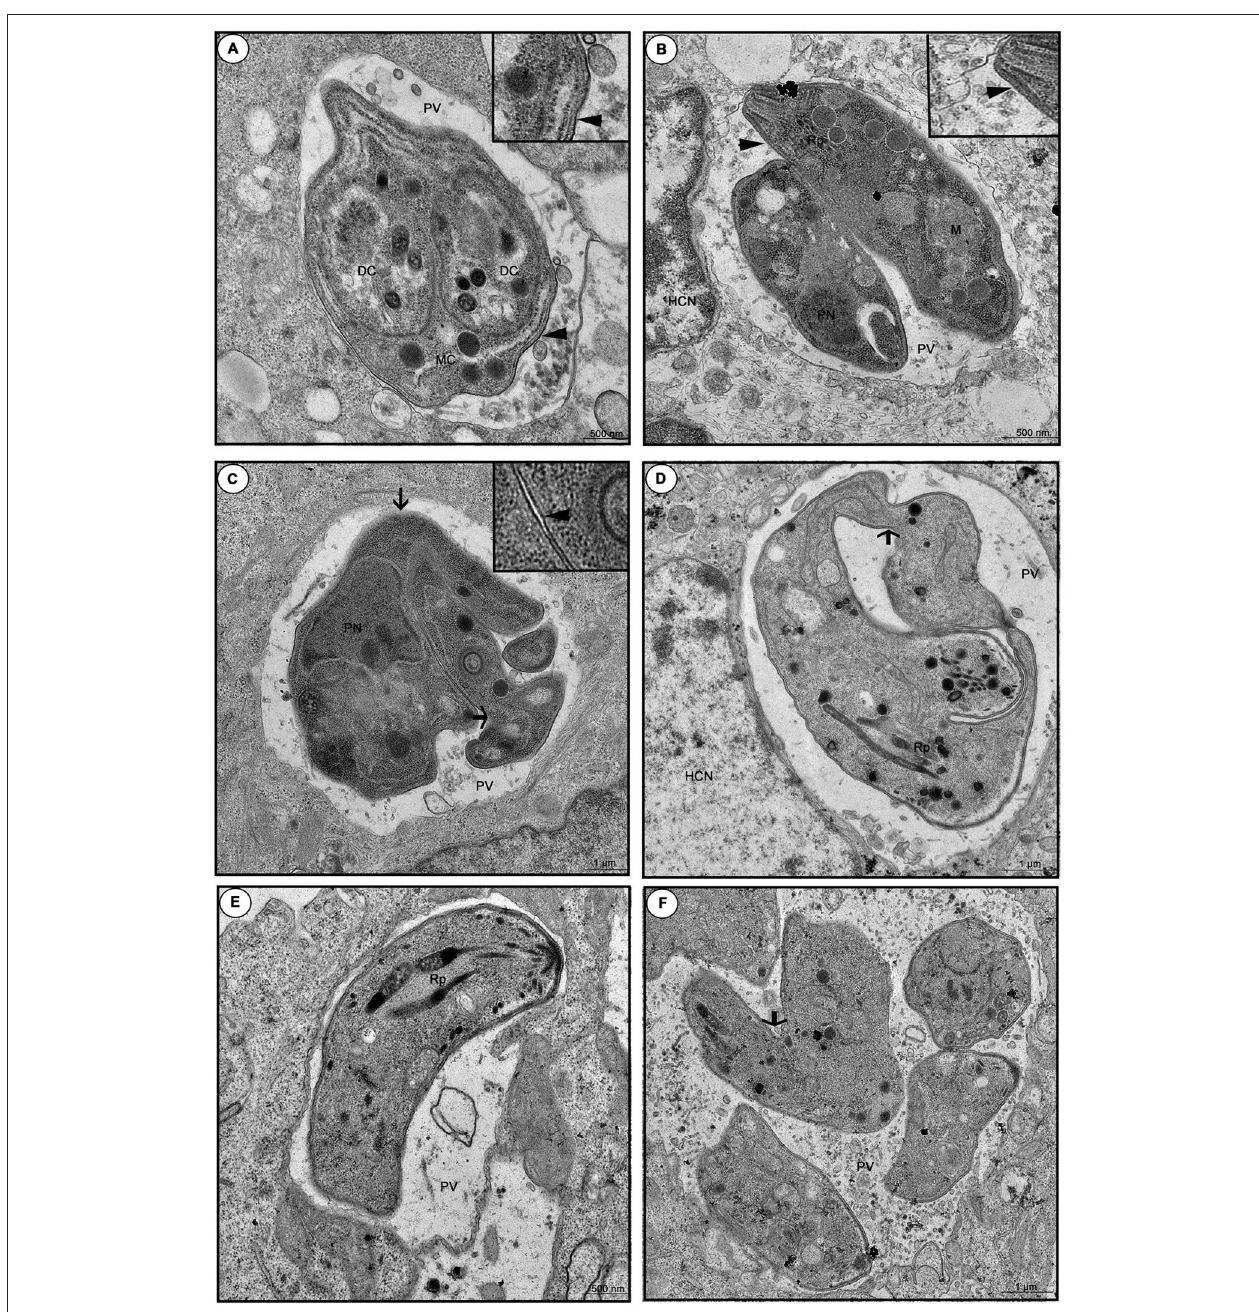
FIGURE 9 | Ultra-structural analyze of tachyzoites in BeWo cells treated with enrofloxacin or toltrazuril. BeWo cells were cultured in 24-well plates (5 × 10 5 cells/well/200 µ L) for 24h, infected with T. gondii (RH-2F1 clone) for 3h, washed with medium to remove extracellular parasites and treated ( µ g/mL) or not with enrofloxacin or toltrazuril for an additional 24 or 48h.Then, the cells were submitted to transmission electron microscopy. Representative electromicrography of untreated BeWo cells infected by T. gondii by 24 (A) or 48h (B), enrofloxacin-treated cells infected by T. gondii by 24 (C) or 48h (D) , and toltrazuril-treated cells infected by T. gondii by 24 (E) or 48h (F) . PV, Parasitophorous vacuole; DC, daughter cells; MC, mother cell; HCN, host cell nucleus; Rp, rhoptries; PN, nucleus; and M, mitochondria of the parasites. Arrows: basal ends (“tethered” parasites); arrowhead: duple membrane. Bar scale: 500nm or 1.0 µ